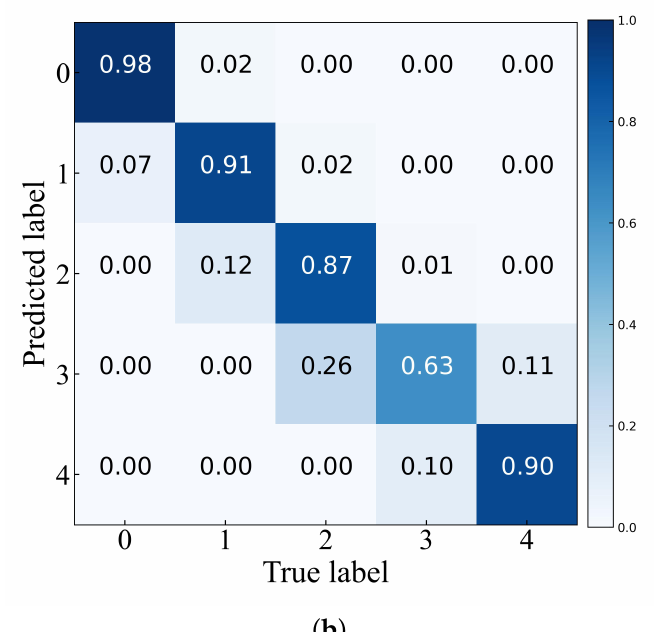
Figure 15. Test dataset and confusion matrix. ( a ) Sample label distribution of the test dataset; ( b ) confusion matrix for the M 3 model on the test